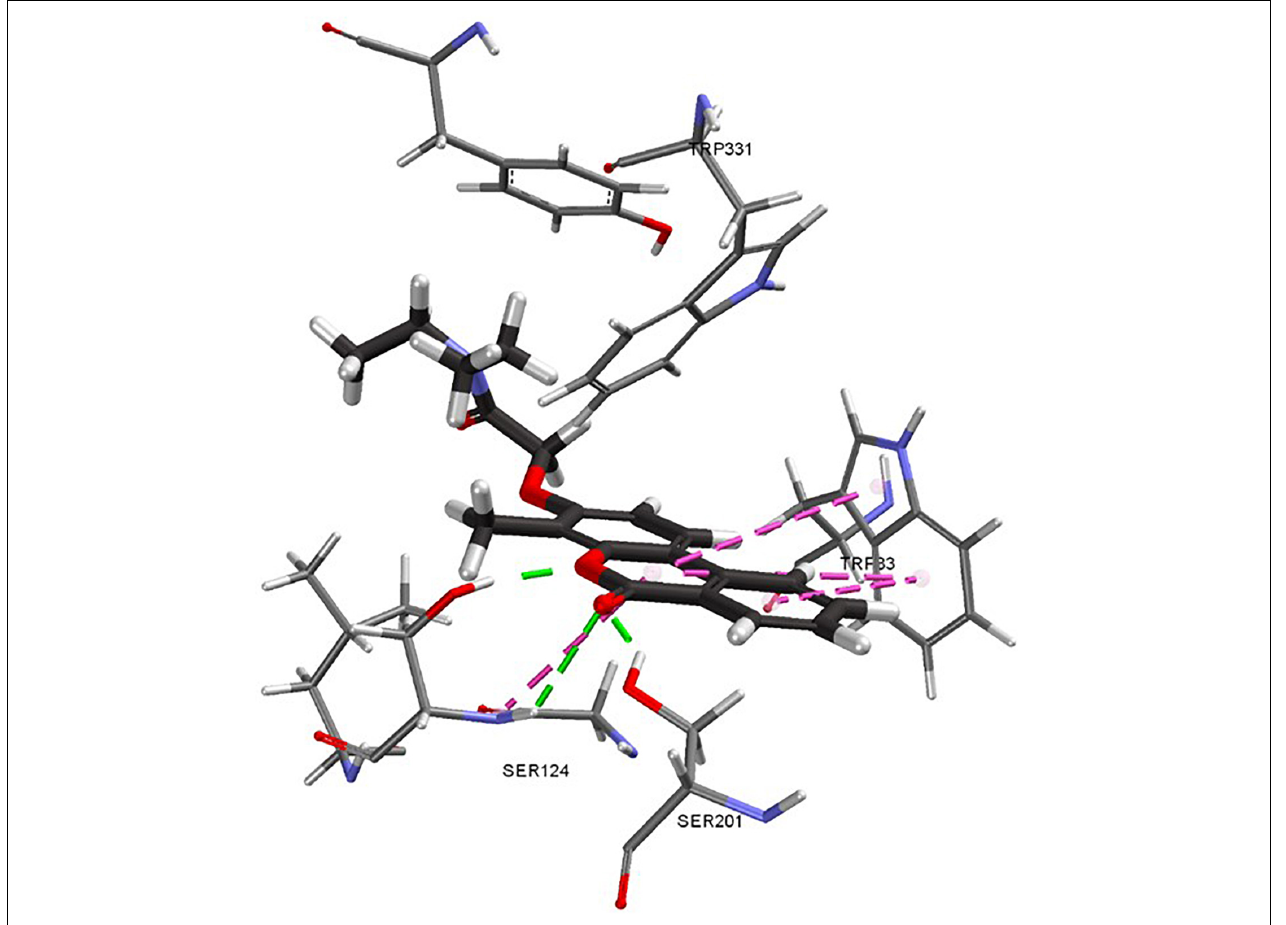
FIGURE 5 | Predicted docking pose of compound 20d . Green dashes indicate hydrogen bonding interactions and pink dashes indicate π - π interactions.